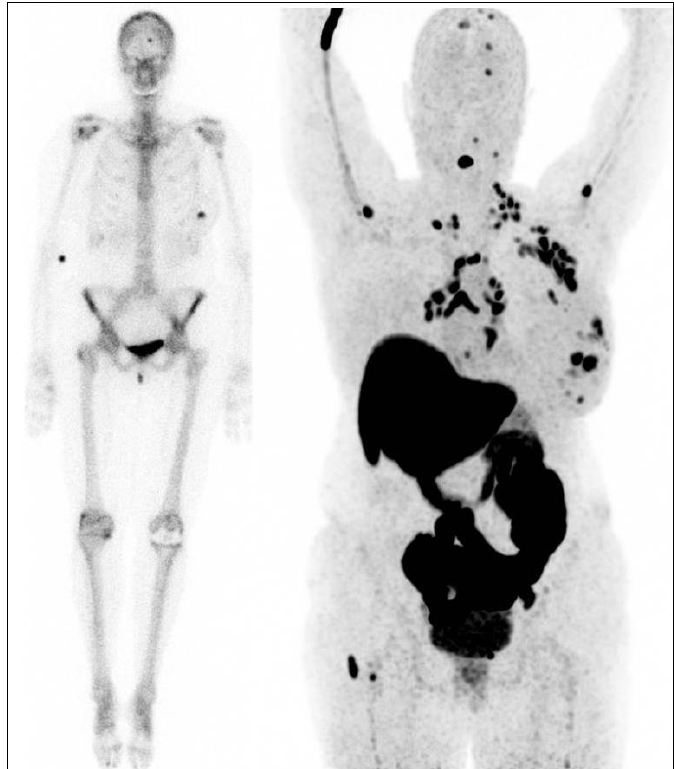
Figure 1. Female patient, known with the estrogen receptor (ER) positive breast cancer in her left breast. Left image: bone scan for dissemination: uptake in the primary tumor in the left breast, and uptake in the skull (metastasis or bone island?). Right image: [ 18 F]-FES-PET with multiple lesions in the left breast, multiple ER positive lymph node metastases (axillae, clavicular regions, neck, mediastinum and hili) and multiple ER positive bone metastases (skull, spine, left humerus, right femur).